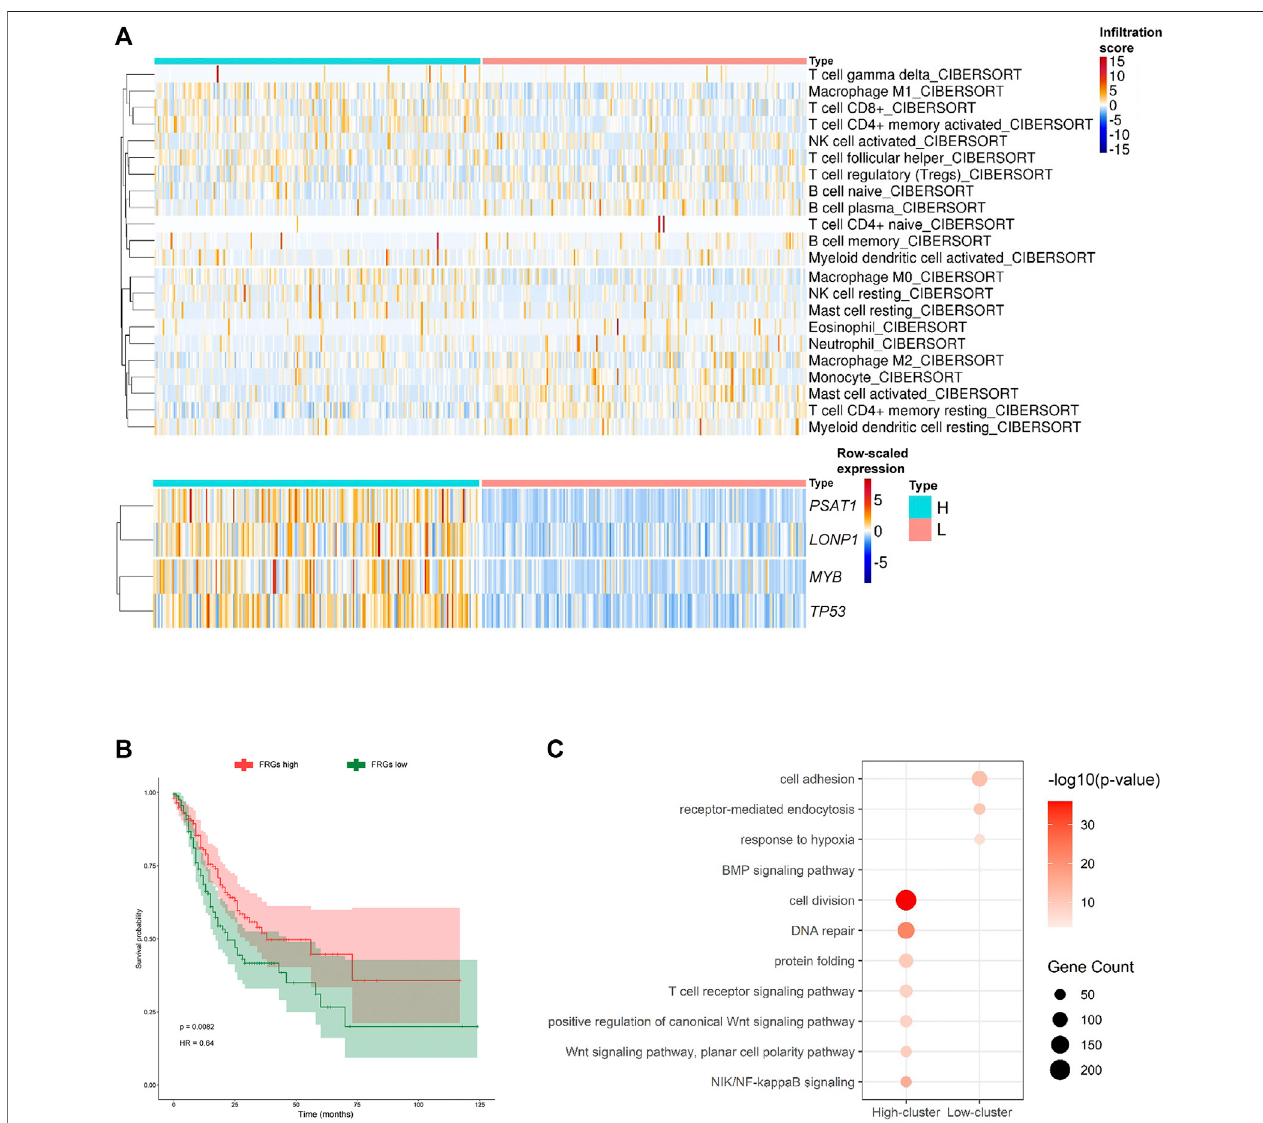
FIGURE 5 | MYB , LONP1 , TP53 , and PSAT1 are related to CD4 + T cell activation. (A) Heatmap showing the in fi ltration scores of each immune cell type in the two subgroups of GC divided by the average expression of the hub FRGs (high-FRG score and low-FRG score group). (B) K-M survival curves and p -values for the two subgroups divided by the average expression of the hub FRGs. (C) Representative GO terms enriched by DEGs between the two subgroups divided by the average expression of the hub FRGs.